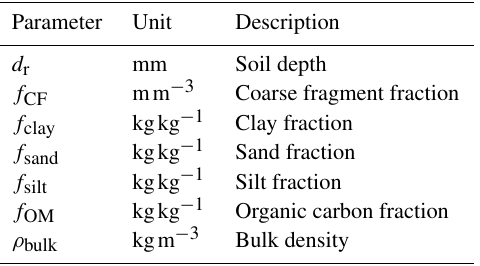
Table 4. Soil-related parameters obtained from the SoilGrids (Hengl et al., 2014) database for each site (Table 3) at 250m res- olution for seven depths (Sect. 3.3). Values for each site (Table 3) are given in Sun et al.